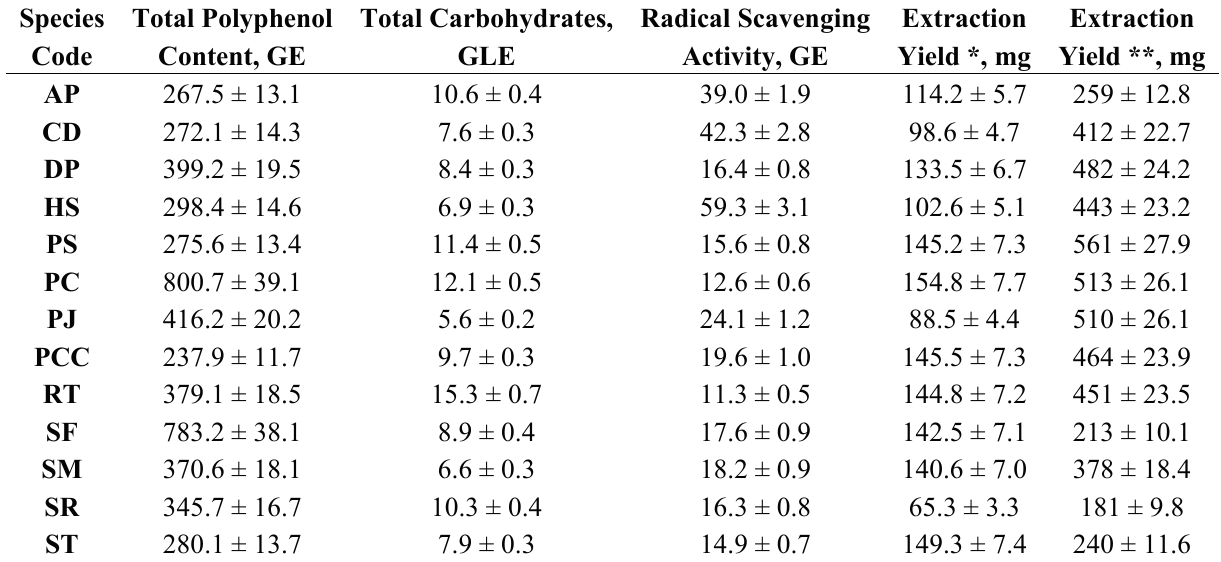
Table 2. Total polyphenolics, total carbohydrates and radical scavenging activity of ethanol extracts * of the studied mosses and the yields of chloroform extracts ** expressed as mg per 100 g of dry moss weight.